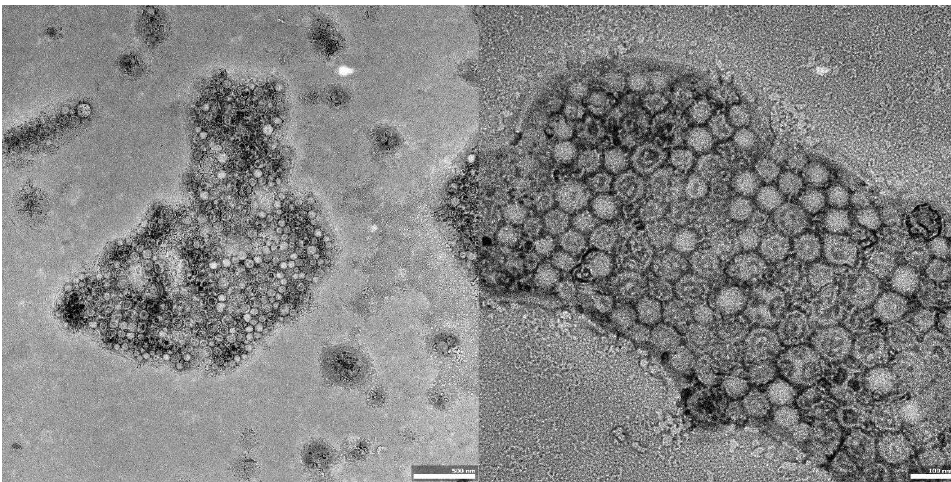
Figure 4. TEM images of UA-PLGA-PEG 5000 nanoparticles. Left panel : UA-PLGA-PEG 5000 magnitude 15 k. Right panel : UA-PLGA-PEG 5000 Magnification: 40 k. Scale bar 500 nm ( left ), 100 nm ( right ).